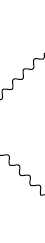
Figure 17 . WIMP-FIMP conversion channel